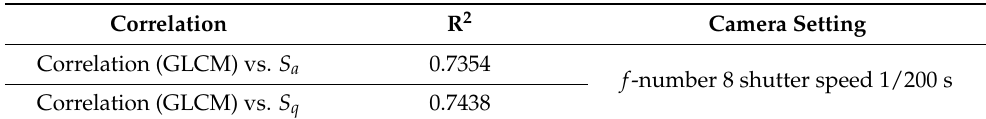
Figure 12. ( a – g ) are correlation plots between characteristic features and roughness parameter with camera setting of f -number of 22, shutter speed 1/200 s and illumination angle of 45 ◦ . Table 2. Tabulation of coefficient of determination value of more than 0.7 for illumination angle of 30 ◦ .